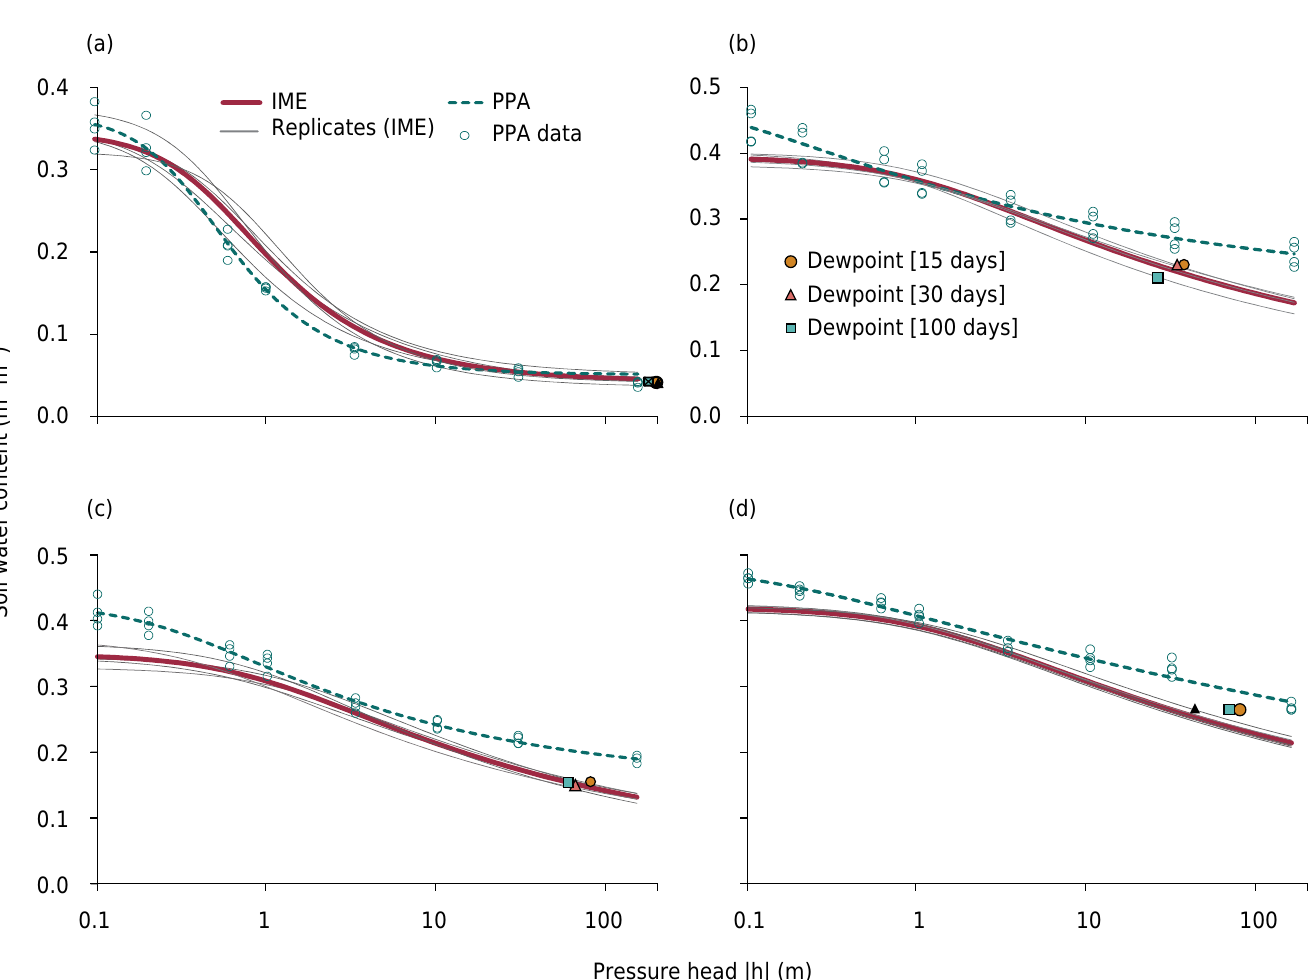
Figure 2. Water retention curves obtained by inverse modeling of a laboratory evaporation experiment (IME) and by tension table/ pressure plate apparatus (PPA); together with dewpoint measurement data for different equilibration times. (a): site#4/layer#1); (b): site#6/layer#1; (c): site#2/layer#1); and (d):